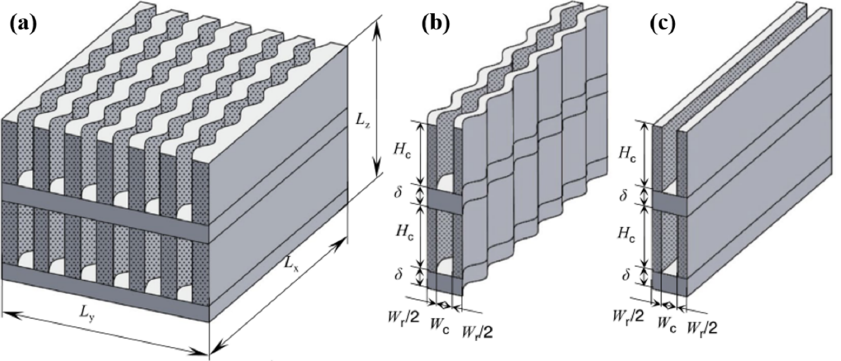
Figure 11. DL-MCHS structural model [128]: ( a ) upper layer wavy and lower layer straight; ( b ) double layer wavy; ( c ) double layer straight.